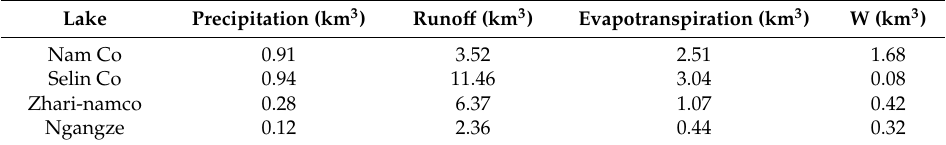
Table 4. Yearly contribution of components to the water balance